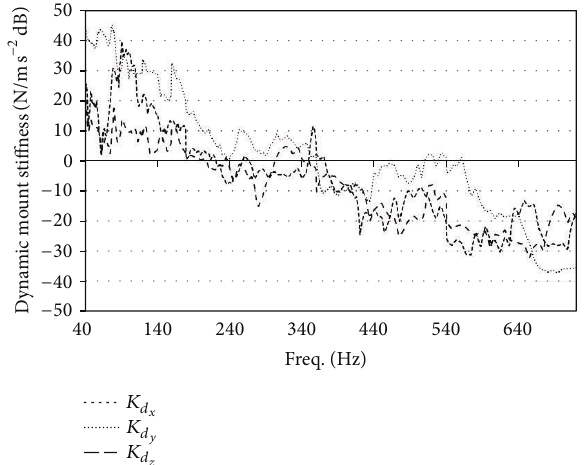
Figure 6: Dynamic mount stiffness derived by simulation.